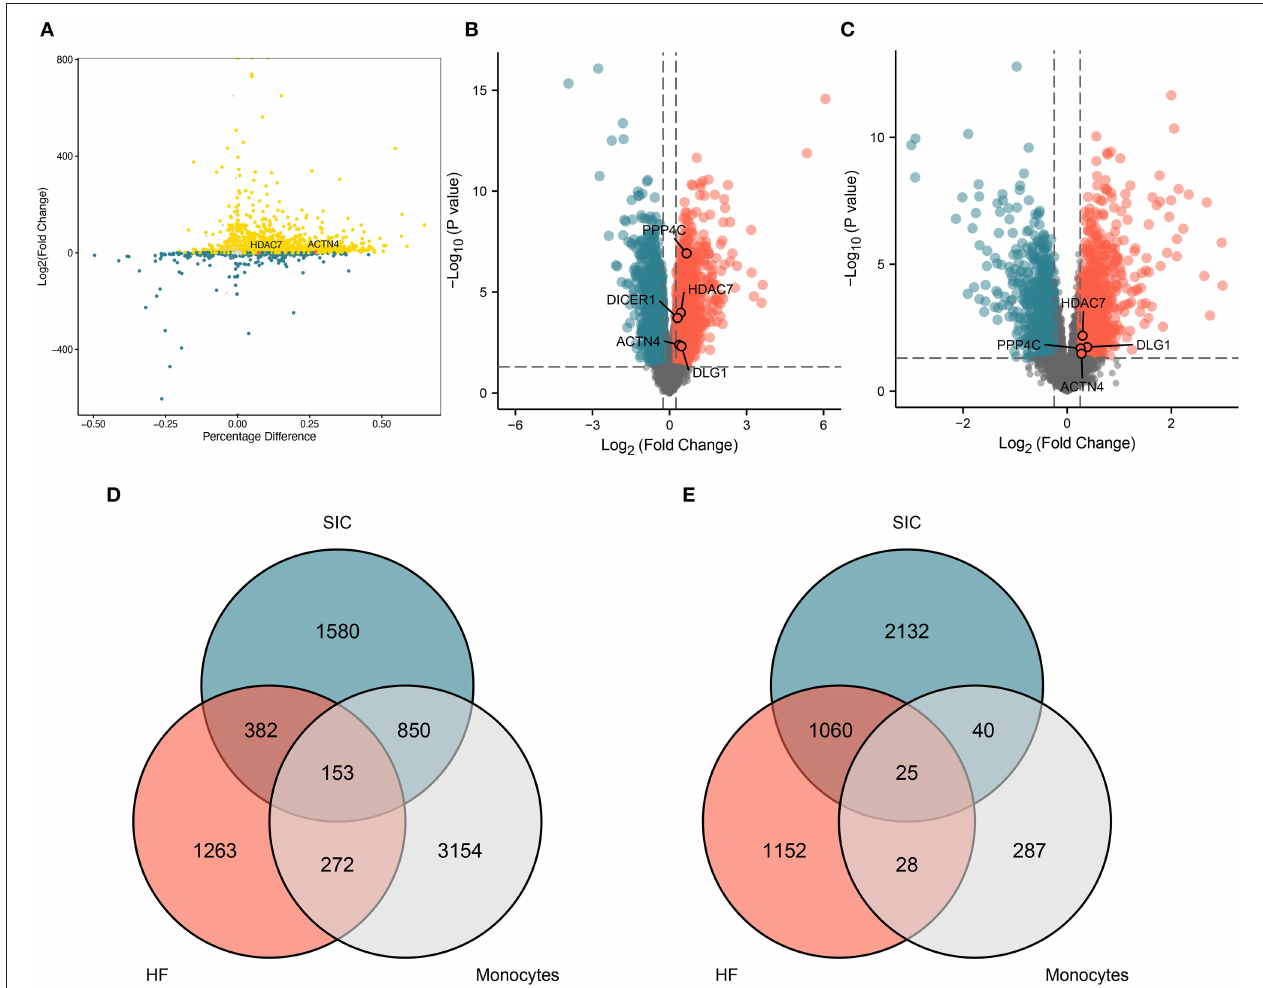
FIGURE 3 | Genes co-differentially expressed. (A) The differentially expressed genes associated with monocytes in sepsis. (B) Volcano plot showing differentially expressed genes associated with SIC. (C) Volcano plot showing differentially expressed genes associated with HF. (D,E) Venn diagram showing the identified differentially expressed genes which are either (D) upregulated or (E) downregulated and are common in septic monocytes, heart failure, and septic cardiomyopathy; (D,E) shows 153 and 25 shared genes,